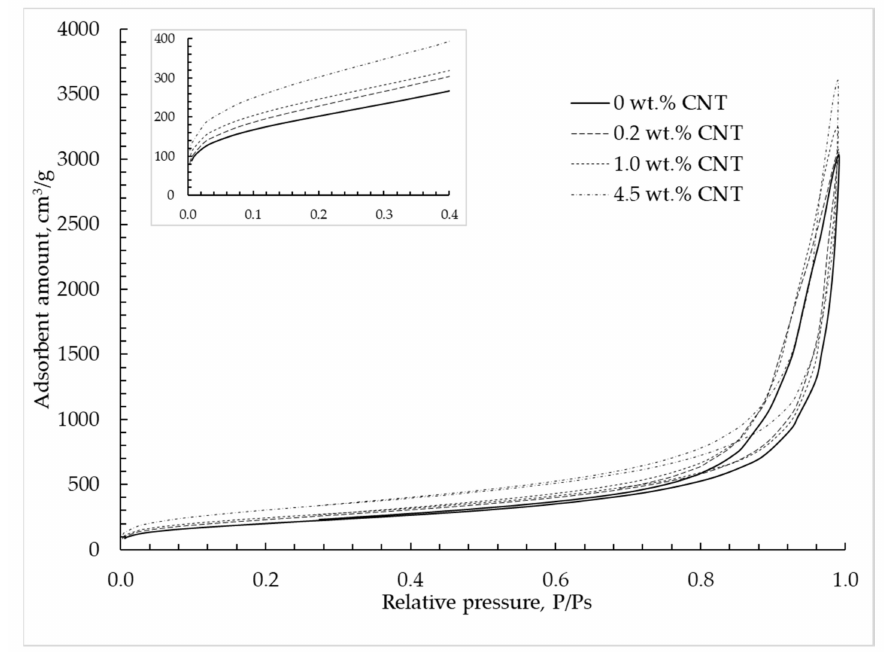
Figure 6. Adsorption–desorption isotherms are provided at 77 K in silica hybrid aerogel microparticles with embedded